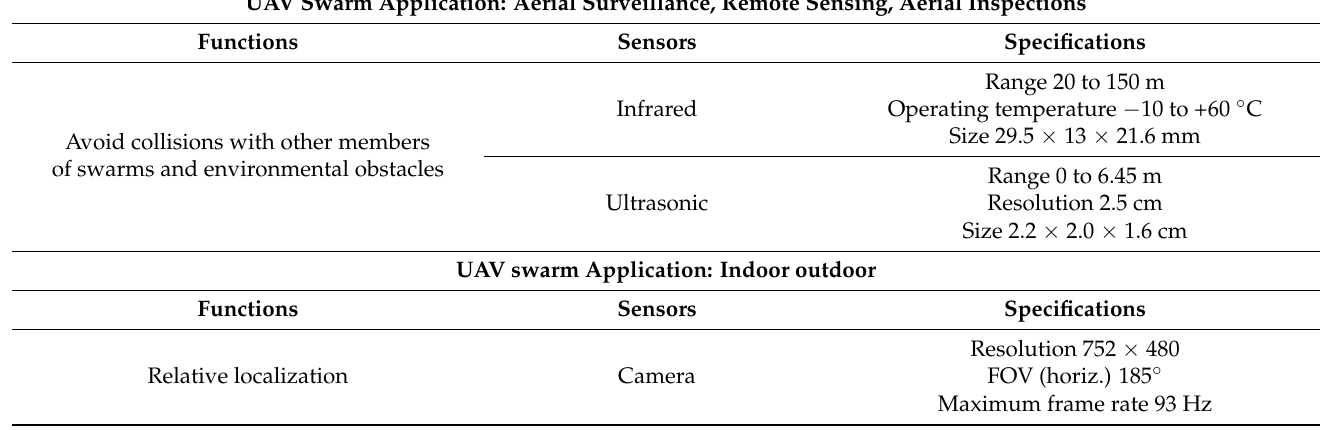
Table 10. Some examples of UAV swarm sensor application